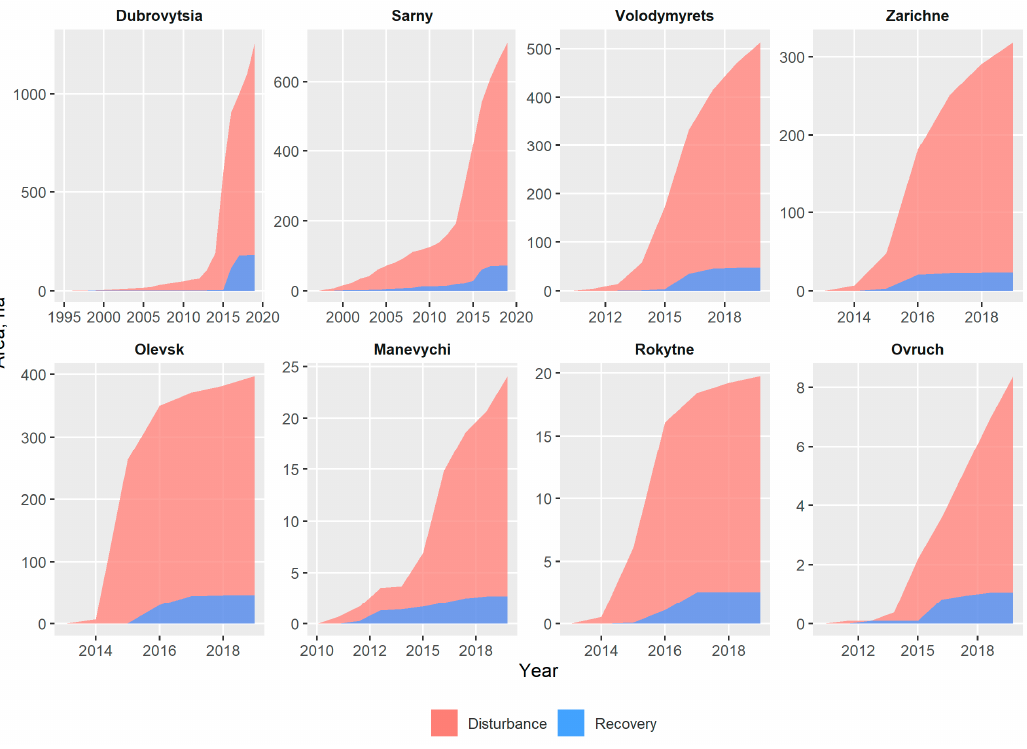
Figure 4. Cumulative disturbance and recovery rates in areas affected by illegal amber mining in Ukraine.